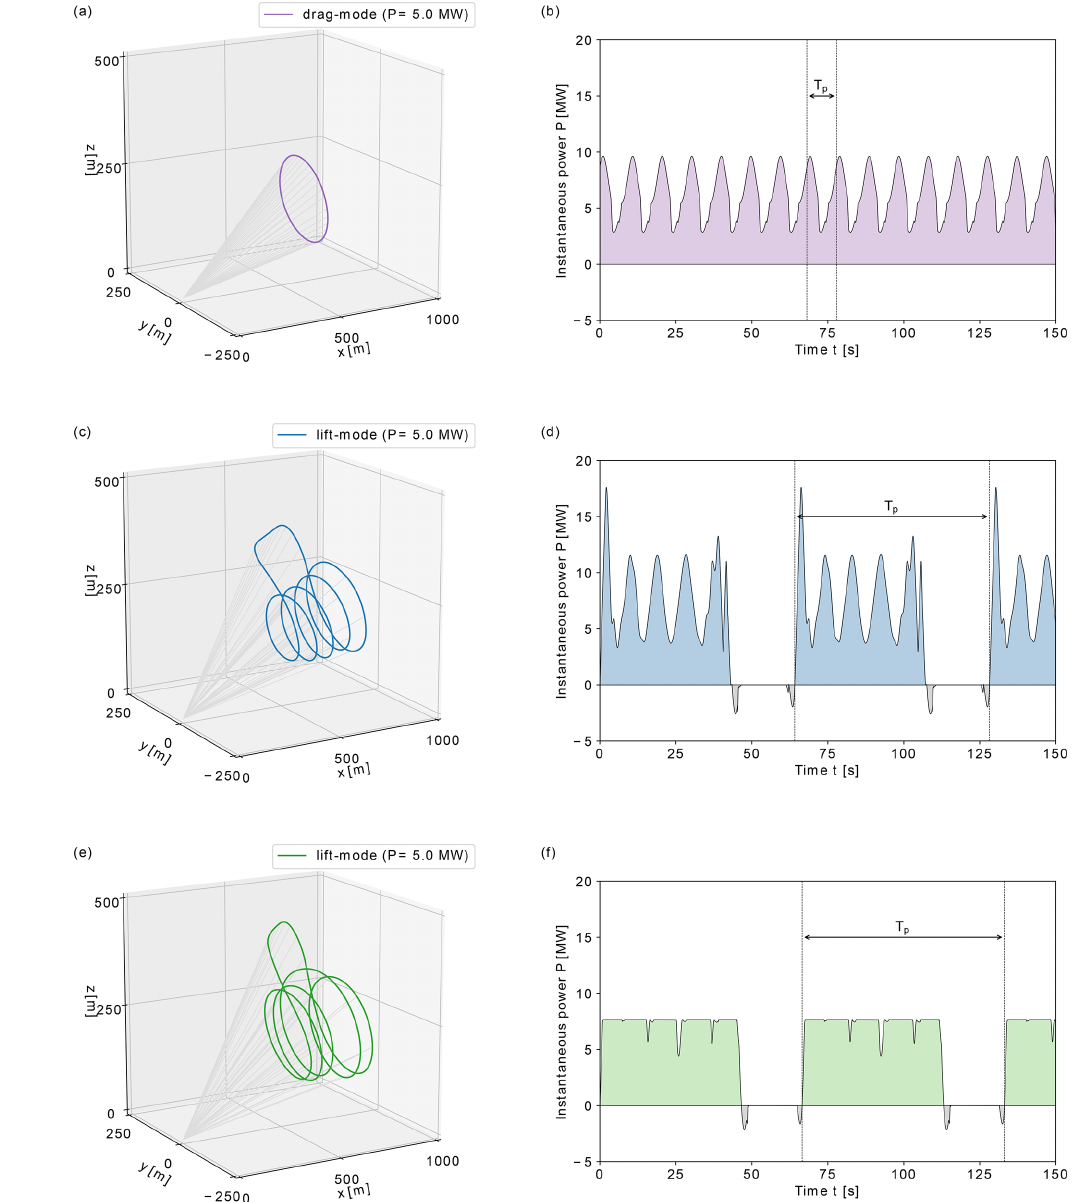
Figure 7. Flight path and instantaneous power of 5MW reference lift- and drag-mode AWE systems optimised for given rated wind speed U D = 12ms − 1 under consideration of offshore conditions. (a, b) Drag-mode AWE system, (c, d) lift-mode AWE system (1) with original bounds, and (e, f) lift-mode AWE system (2) with induction-based limitation of reel-out